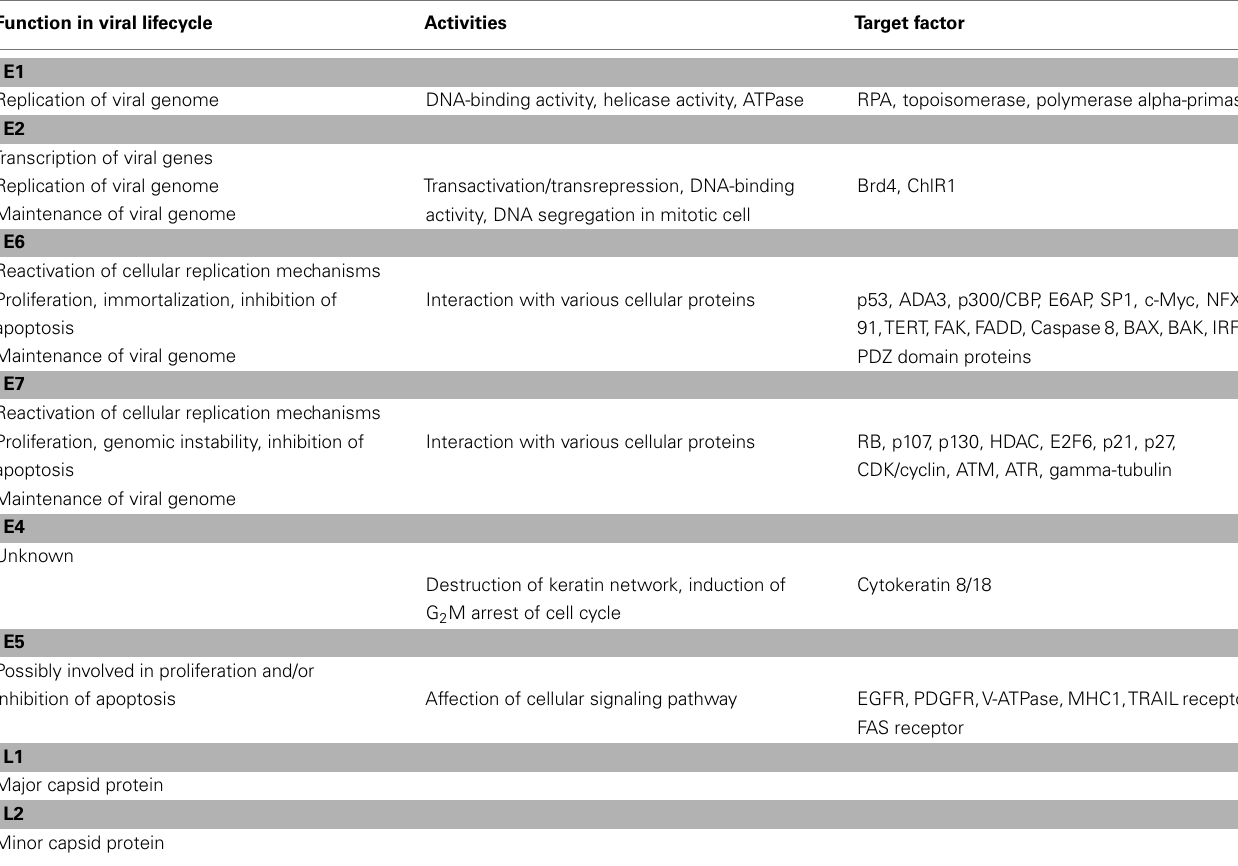
Table 1 | Summary of HPV gene